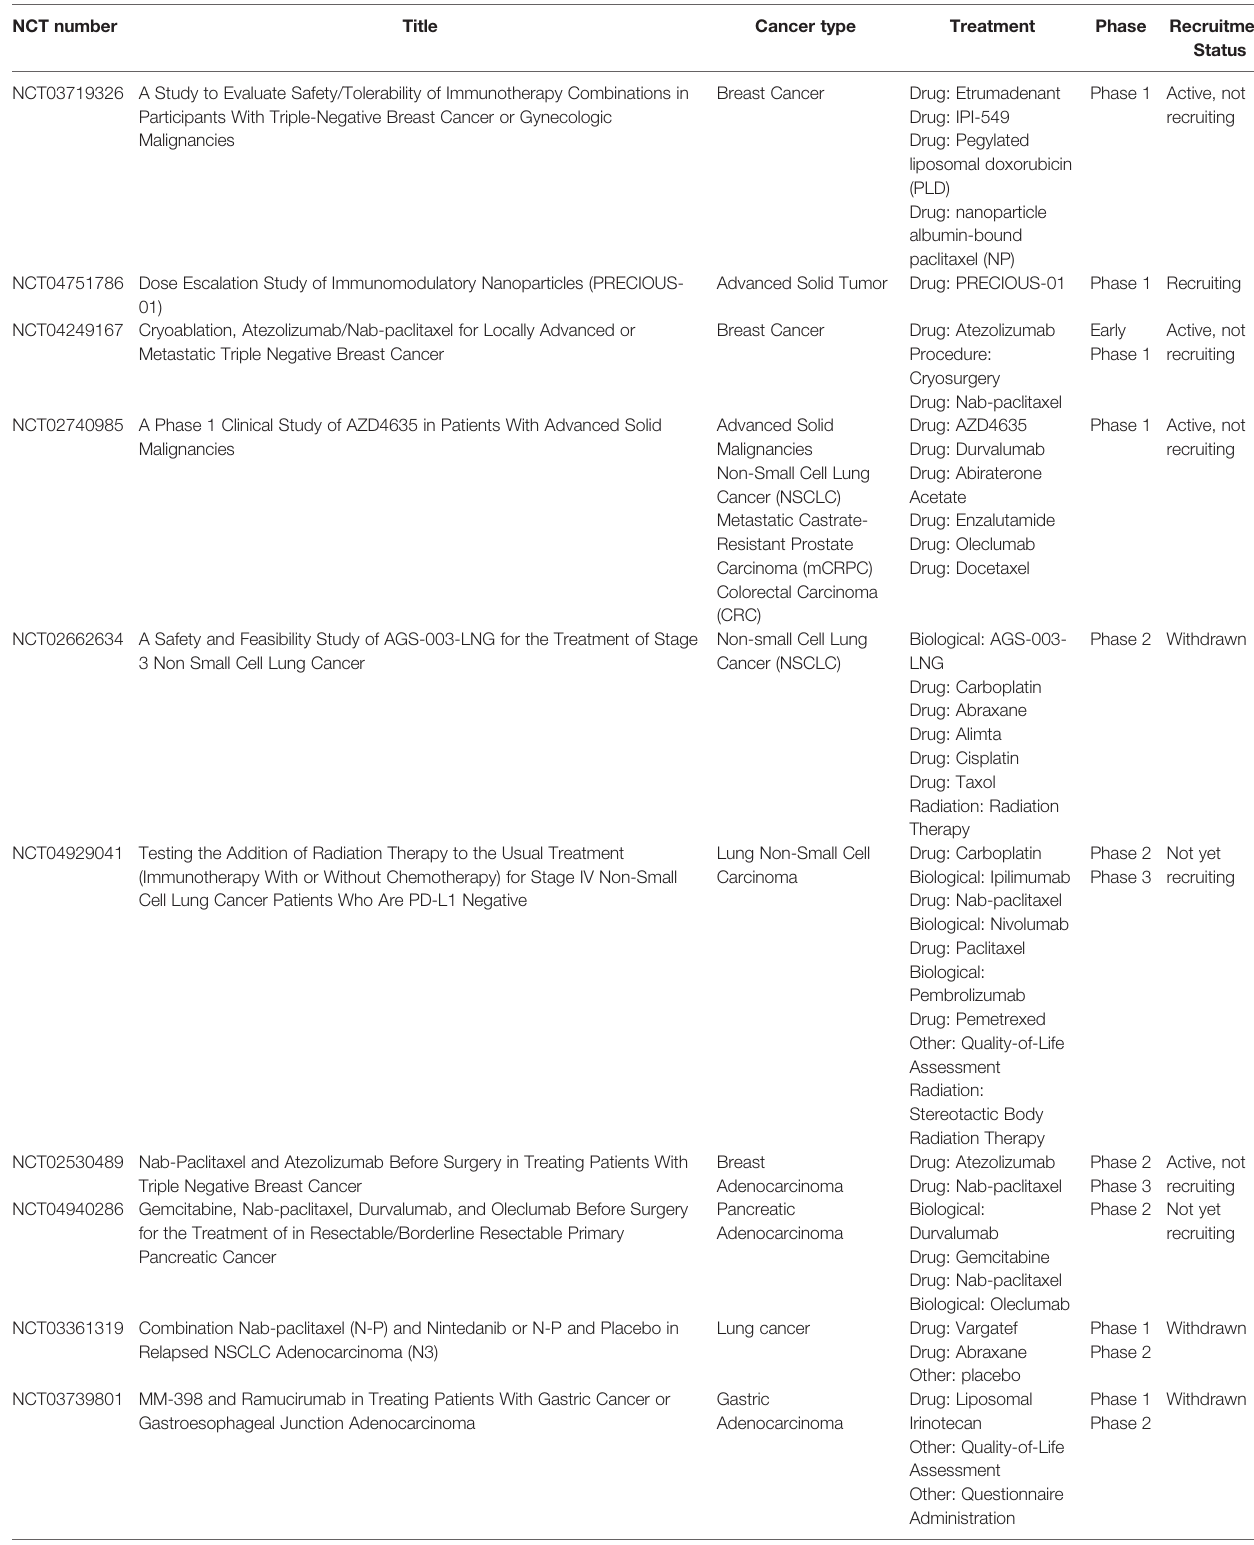
TABLE 2 | Clinical trials about immunotherapy based on